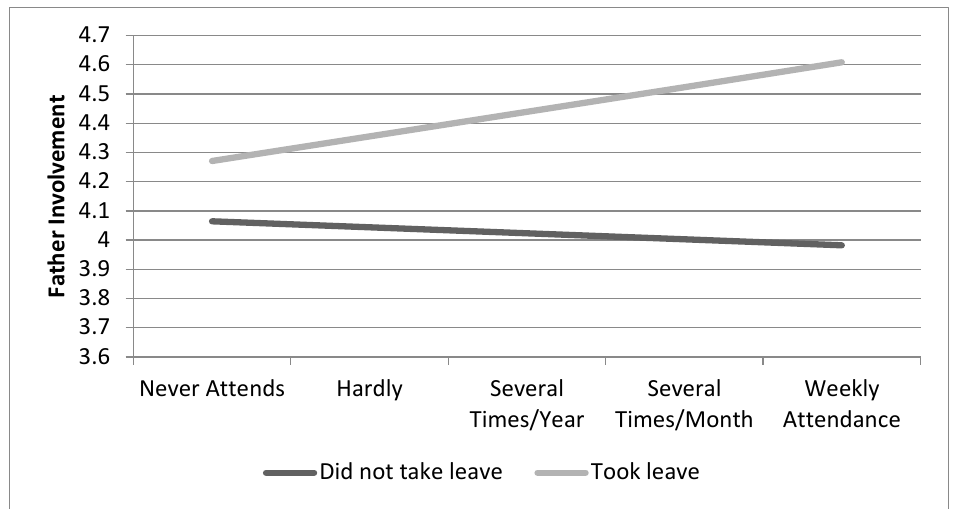
Did not take leave Took leave Figure 1. Predicted values of the relationships between paternity leave-taking, religious participation, and father involvement.